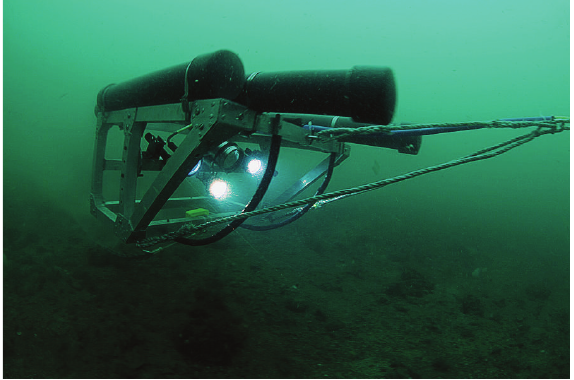
Figure 2: The towed flying array mounted with high definition